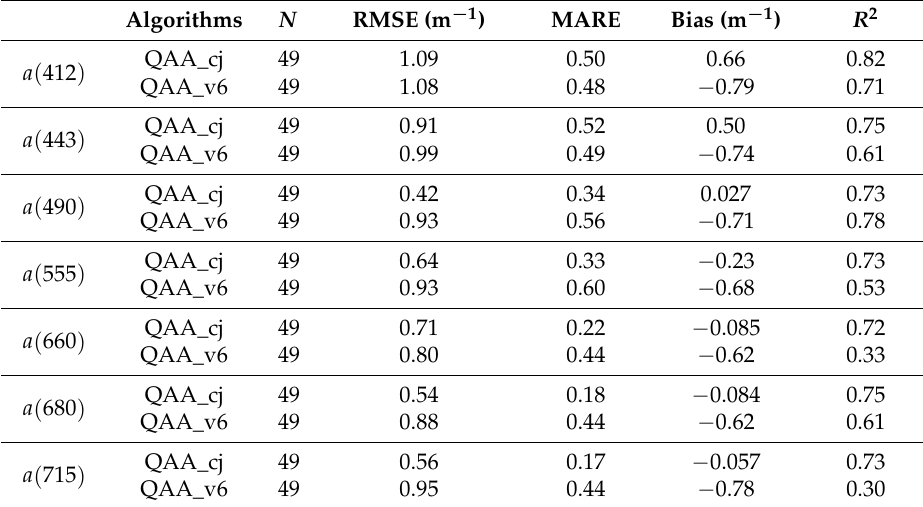
Table 4. Comparison statistics of QAA_cj and QAA_v6 based on in situ dataset collected from the Changjiang estuarine and coastal waters ( N is the number of validation data).